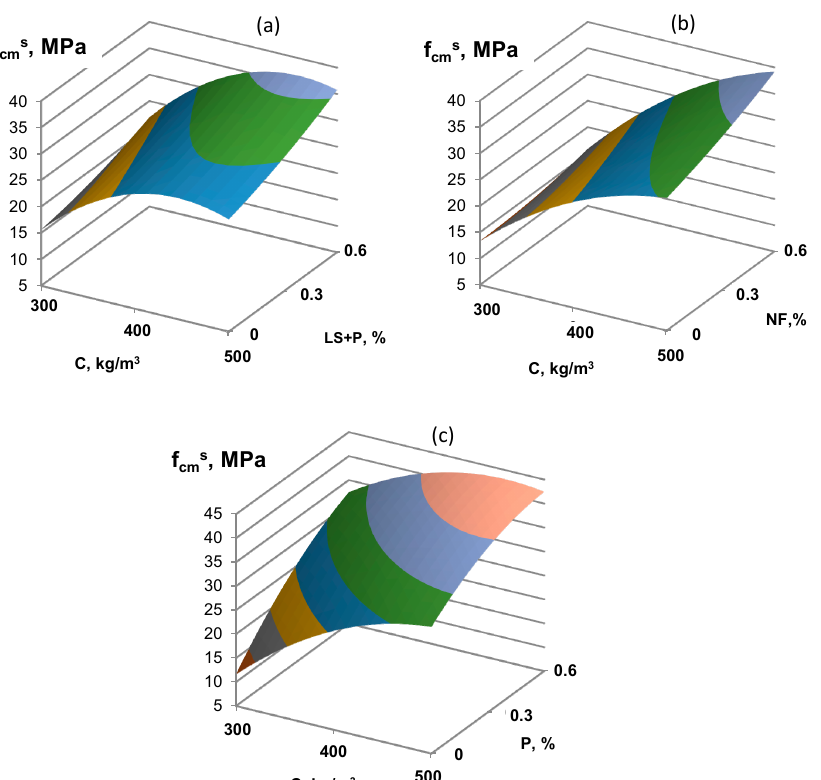
Figure 3. The combined effect of cement consumption and various types of superplasticizers (NF ( a ), P ( b ), and P+LS ( c )) on low-clinker slag Portland cement concrete strength after steaming.